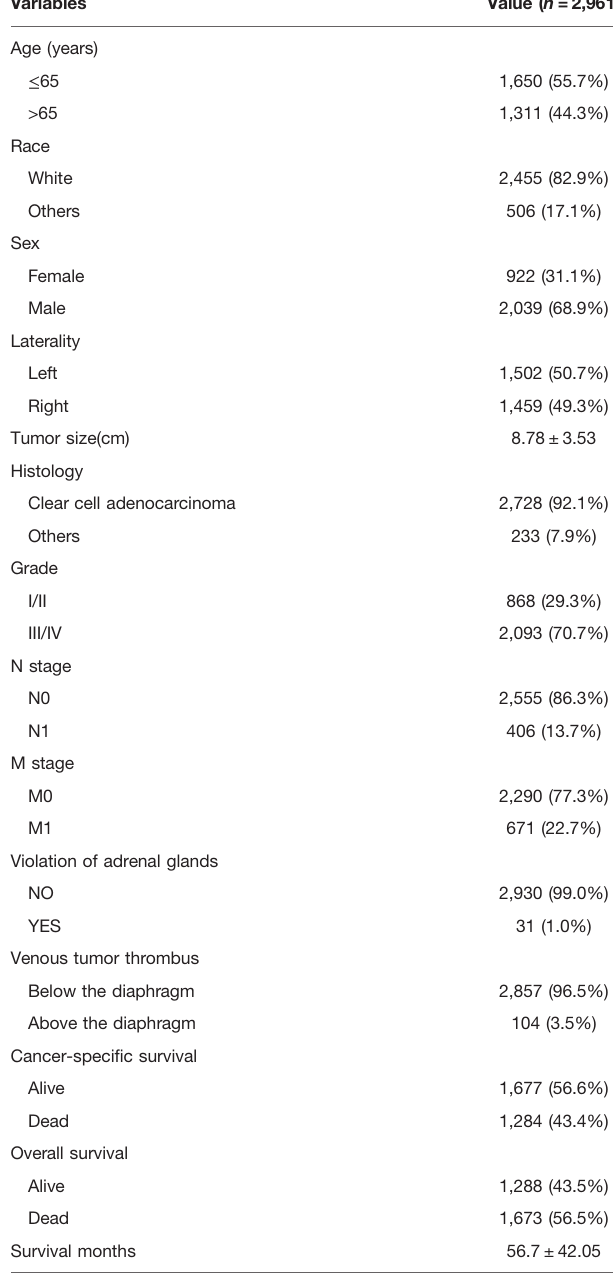
TABLE 1 | Clinicopathological features of renal cell carcinoma patients with venous tumor